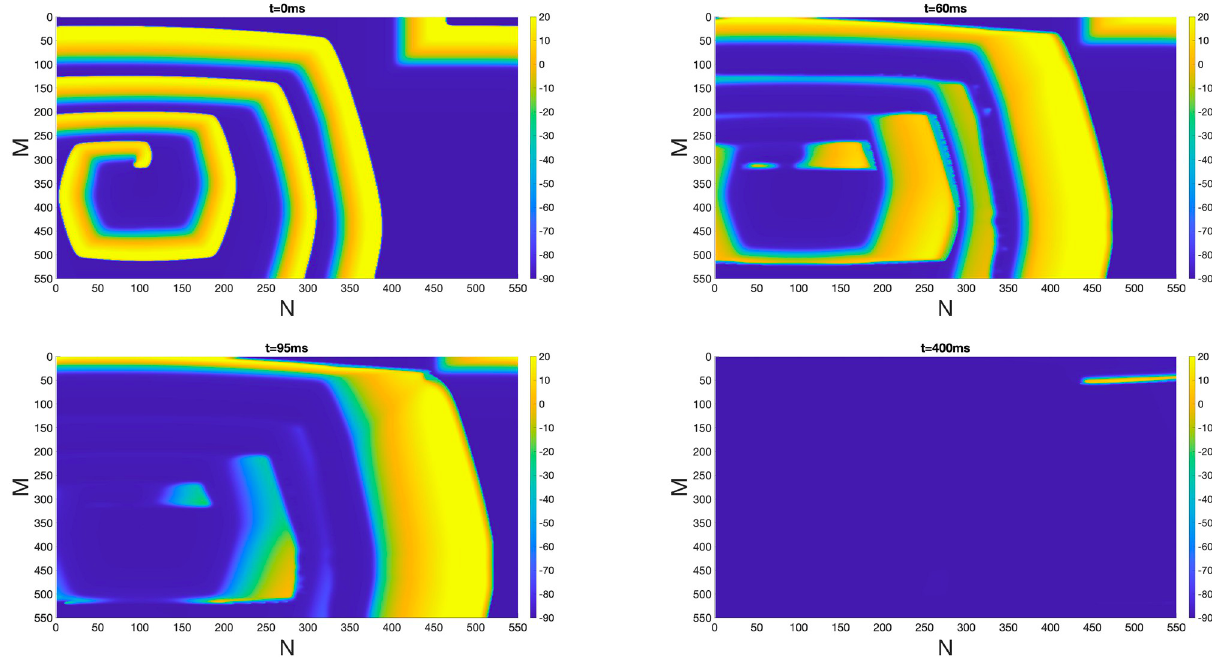
Fig 5. Inhibition of reentry in a poorly coupled tissue under homogeneous EpC. Suppression of reentry generated in poorly coupled tissue in the presence of homogeneous EpC at d cleft = 8 nm. Colorbar indicates V